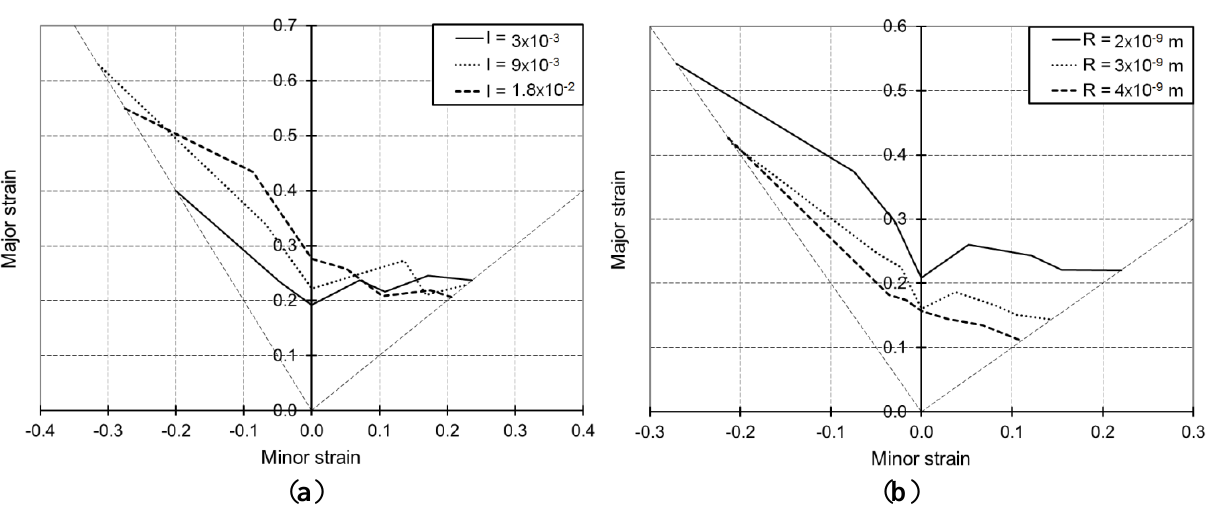
Figure 6. Simulated FLDs associated with linear loading paths for the IF – Ti single-phase steel as obtained with the Bifurcation–EPSC model: Effect of the model parameters associated with the randomly distributed dislocation